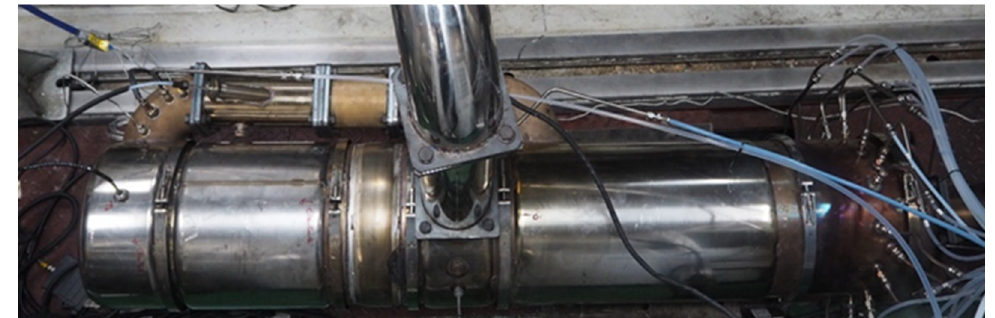
Figure 10. Selective catalytic reduction (SCR) system geometry in a Hyundai D6CC heavy-duty diesel engine.